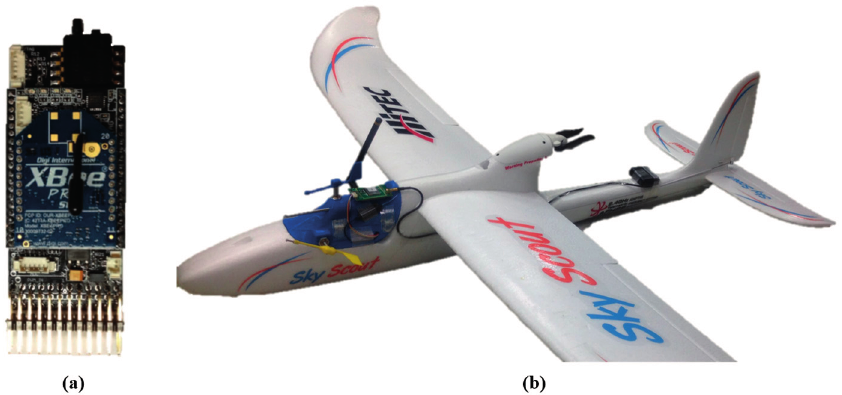
Figure 2. ( a ) Developed ARM Cortex-M3-based FCC; ( b ) UAV